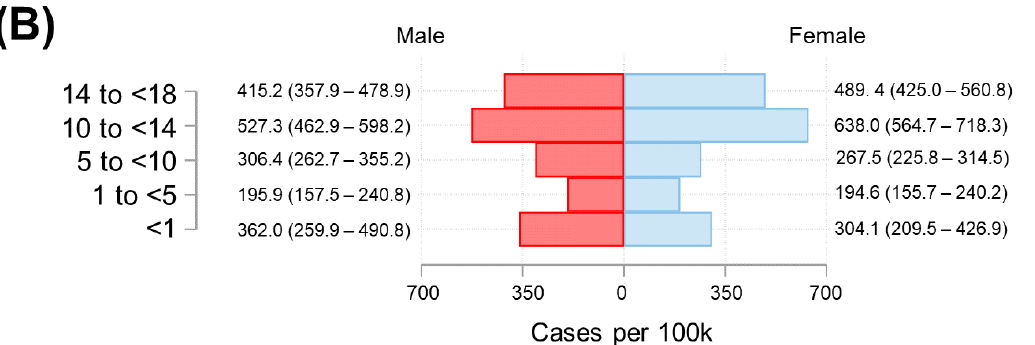
Figure 5. Distribution of cases by gender and age, as of 31 April 2021. The distribution of confirmed new cases in Cartagena and other municipalities of Bolívar per 100,000 population was plotted in Panel ( A , B ), respectively. The 95% confidence intervals of the cumulative incidences were in parenthesis.